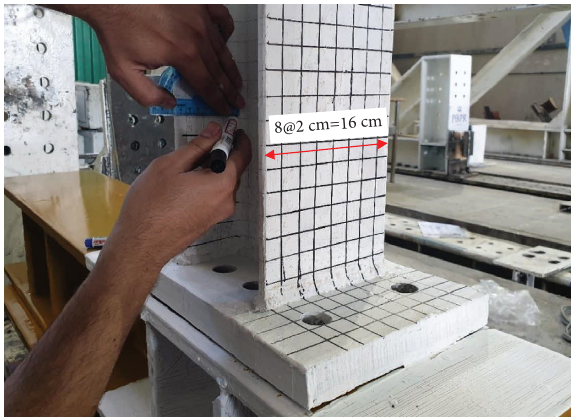
Figure 2: Grid dimensions.